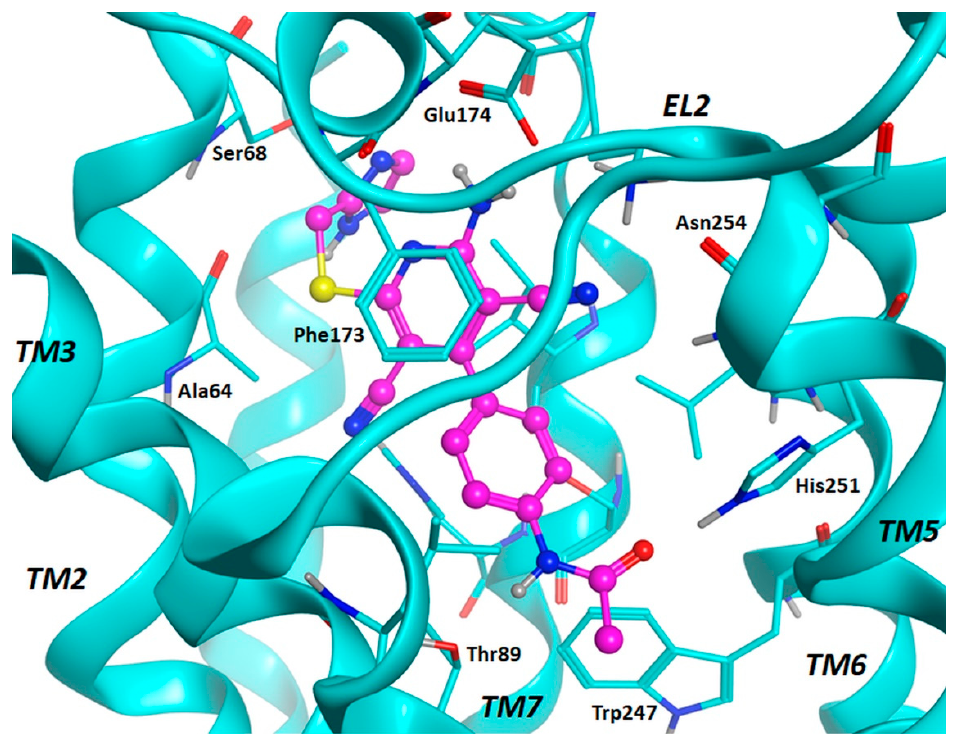
Figure 3. Docking conformations at hA 2B AR. The simulated binding mode of compound 6 is shown, with detail of key receptor residues involved in ligand–target interaction.